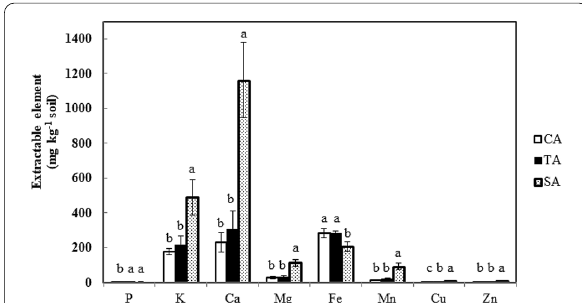
Fig. 2 Soil extractable elements of tea plantations. The extractable elements including P, K, Ca, Mg, Mn, Cu, and Zn from the CA, TA, and SA soils were determined by ICP‑MS. Results are shown as mean